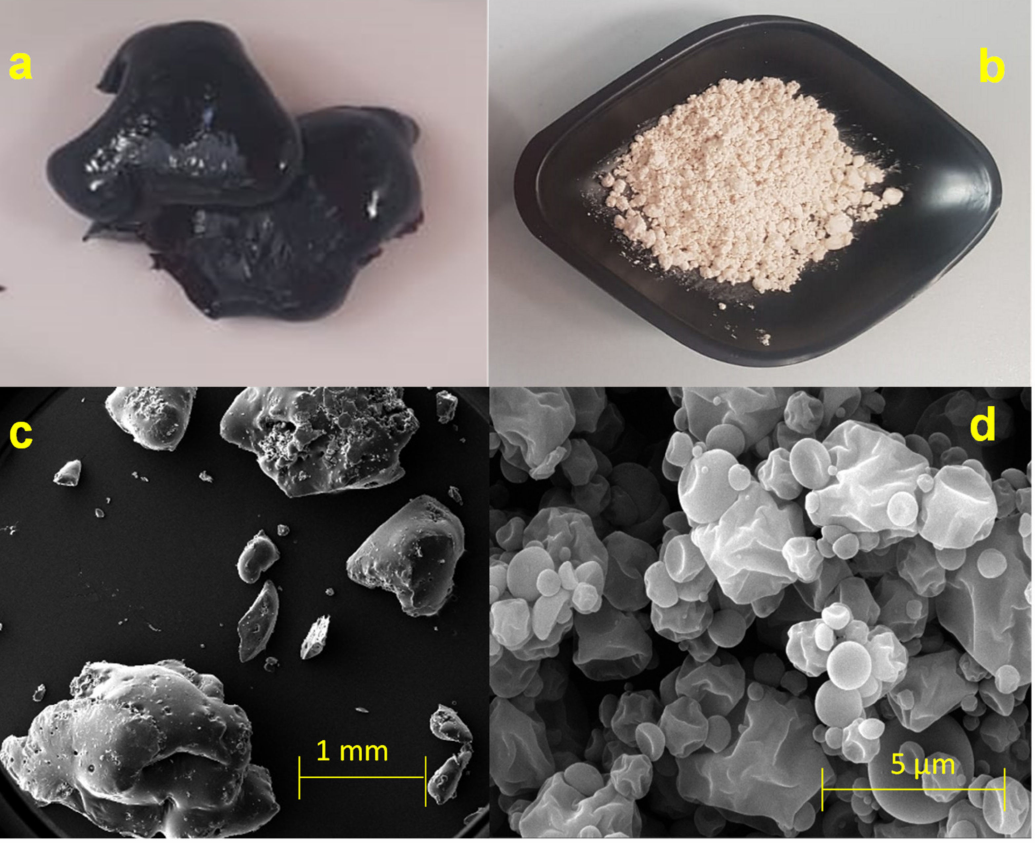
Figure 7. Macroscopic and microscopic images of AGL-28 extract ( a , c ) and MPA powder ( b , d ) after 6 months of harsh storage